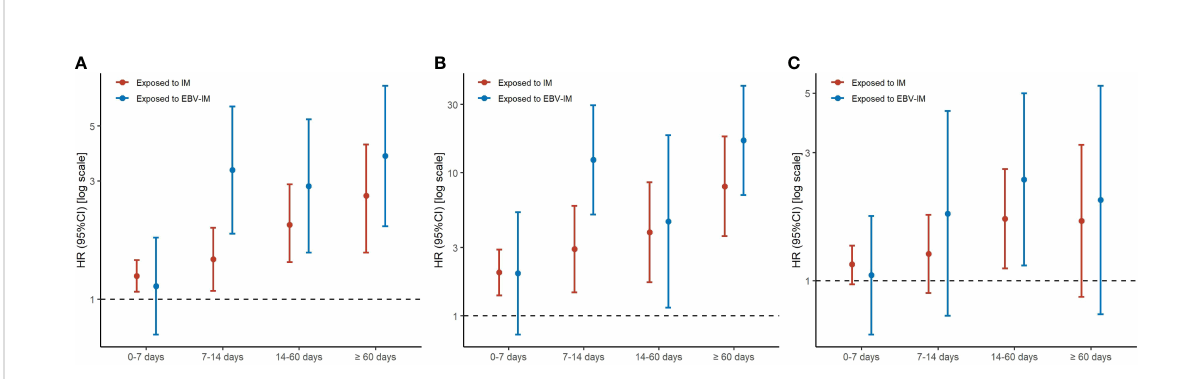
FIGURE 1 Risks of Subtypes of Malignancy According to Infectious Mononucleosis (IM) with or without Complication. Graph shows adjusted hazard ratios (HRs) with error bars representing 95% con fi dence interval (CIs) for total malignancy (A) , hematologic malignancy (B) , and other malignancy excluding hematologic malignancy (C) . The analyses were adjusted for sex, maternal age at delivery, parity, maternal education, maternal residence, and parental malignancy